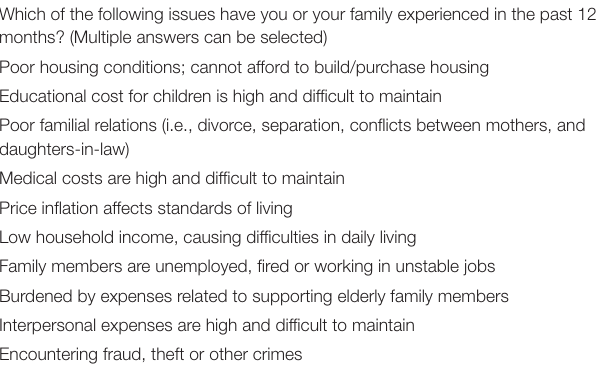
TABLE 2 | Institutional evaluation measure. Individuals’ evaluation of the institutional system was computed based on responses to the following items: trust in relevant governing bodies; evaluations of social welfare systems and local government efficiency.